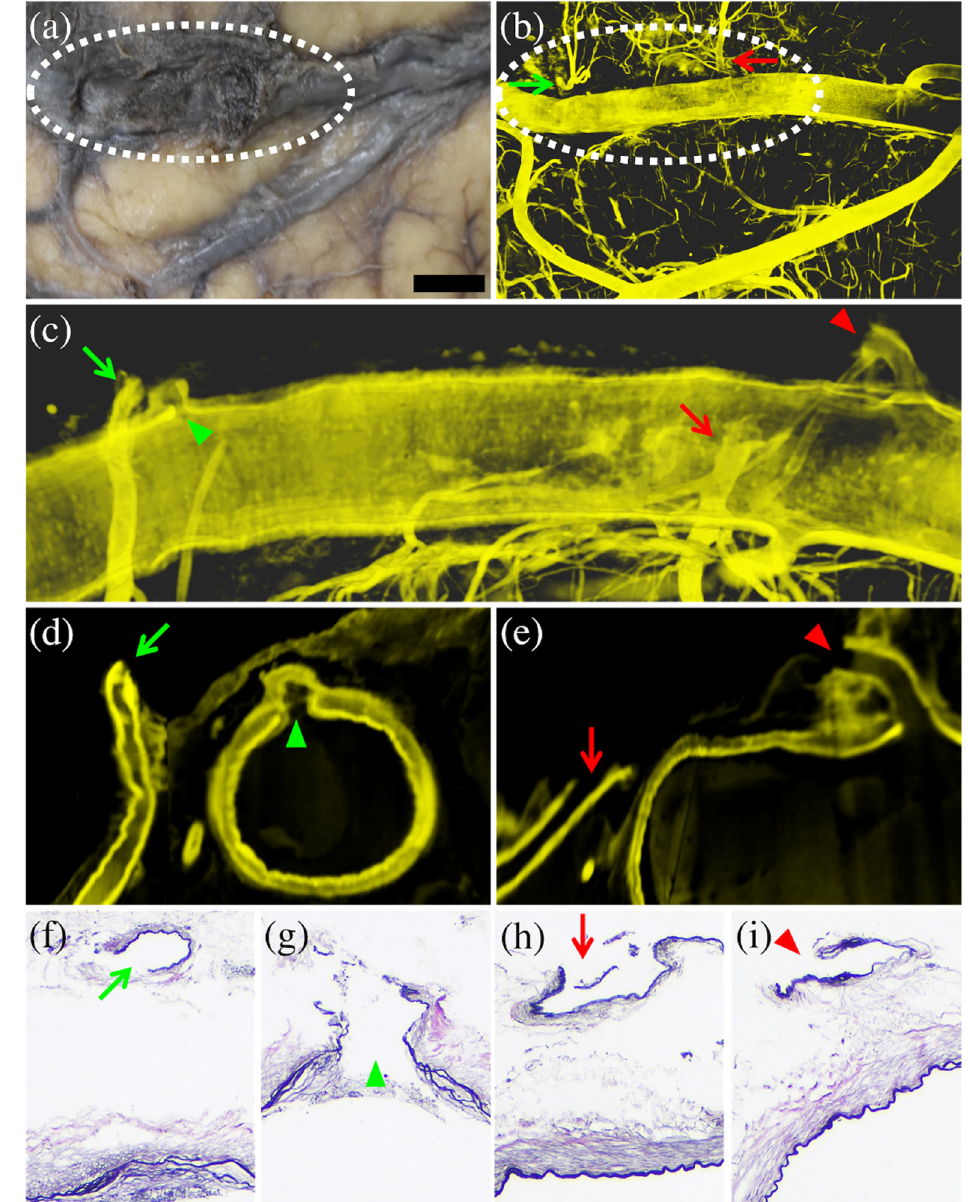
Figure 4. Comparison of macroscopic and histopathological images with CUBIC images in case 3. The enlarged macroscopic (formalin-fixed) image ( a ) could not reveal the presence of arterial ruptures or “twigs” due to bleeding on the surface (dotted circle). The 3D-CUBIC image ( b ) detected two small branches (arrows) at the bleeding site (dotted circle), neither of which was continuous with the cortical artery. The magnified lateral view of the 3D-CUBIC image ( c ) and the cross-sectional CUBIC images ( d ) and ( e ) of the bleeding area showed the proximal (arrowheads) and distal (arrows) ruptured ends of the two different arterial branches. These images indicated that one rupture occurred at the bifurcation of the cortical artery (green) and the other approximately 7 mm from the bifurcation (red) immediately after further branching. The histopathological (Elastica van Gieson staining) images ( f – i ) detected the four corresponding ruptures shown in the CUBIC images, but they could not display their positional relationship to each other. Each marker (arrow or arrowhead, green or red) in Figures b–i corresponds to each rupture part. The bar (on the lower right side of ( a )) is equal to 2 mm for ( a , b ), 500 μ m for ( c ), 400 μ m for ( d , e ) and 200 μ m for ( f – i ). In case 4, magnified macroscopic observation did not reveal the rupture of the corti- cal artery or small branch, despite bleeding deposits not being detected at the rupture site. Clearly, 3D-CUBIC imaging showed the cortical artery ruptured at the root of a small